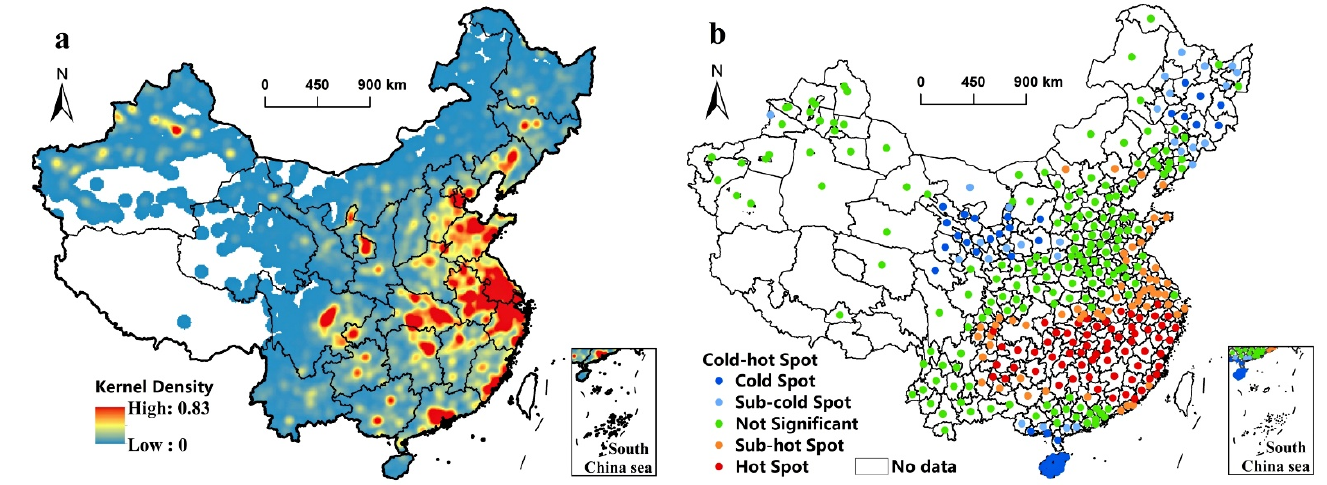
Figure 5. Kernel density estimation of newly added industrial land points from 2010 to 2019 in China ( a ); Cold–hot spot analysis of newly added industrial land area of prefecture-level cities from 2010 to 2019 in China ( b ).